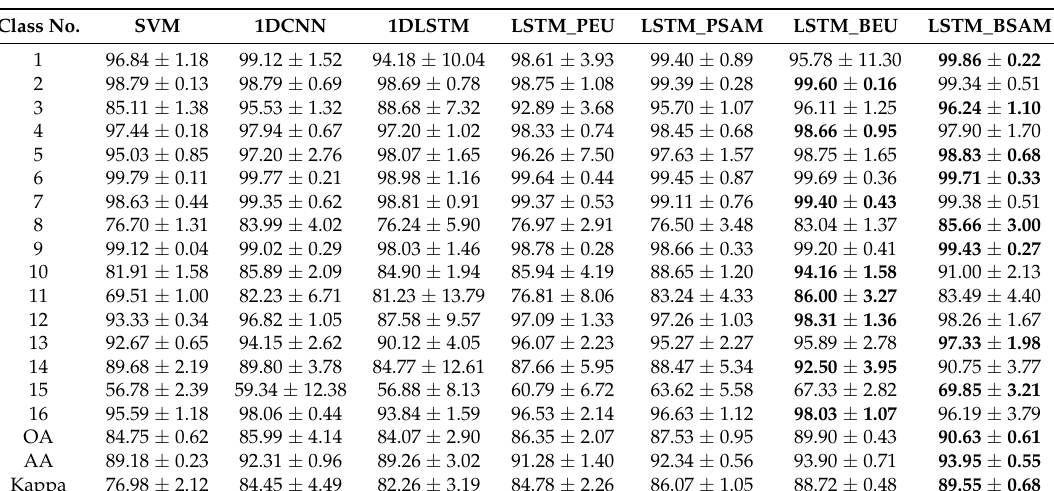
Table 4. Comparison of different classification results for the Salinas image (%), where